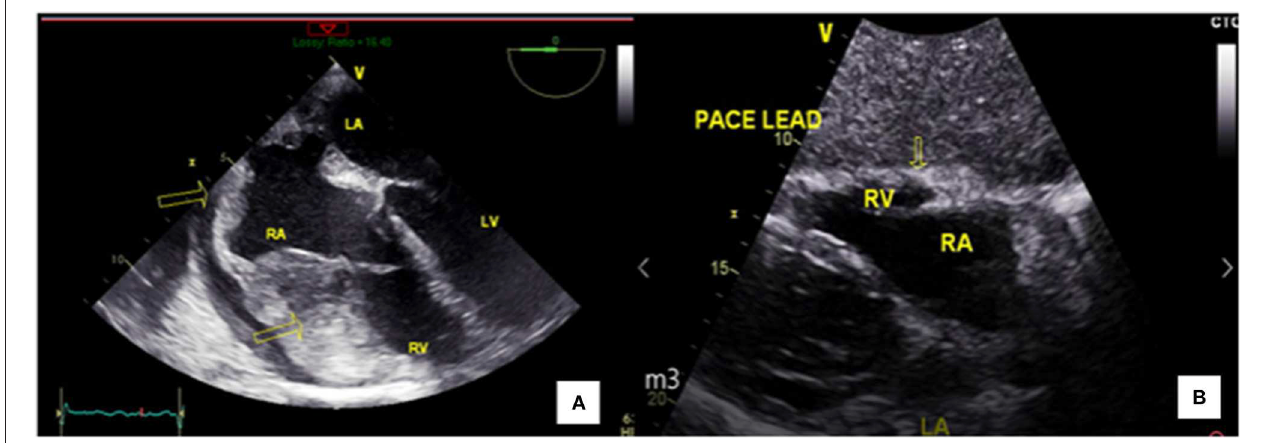
FIGURE 3 | Complete remission after chemotherapy. (A) Transesophageal echocardiography revealing right ventricular infiltration before chemotherapy. (B) Transthoracic echocardiography revealing remission after